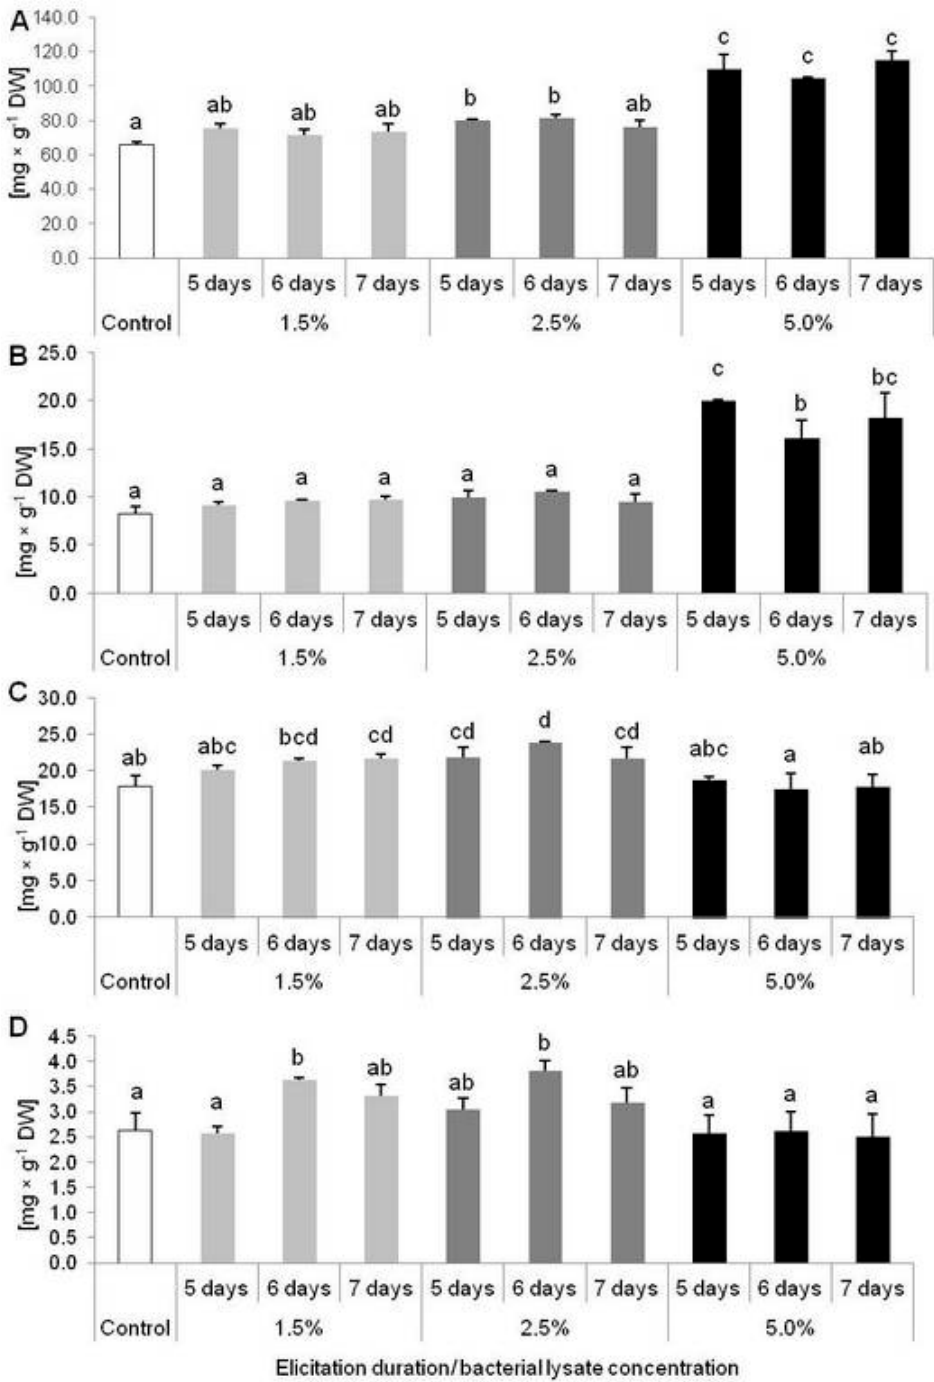
Figure 5. Accumulation of phenolic compounds in Dionaea muscipula plants after 5, 6 and 7 days of elicitation with Cronobacter sakazakii lysate in different concentrations: ( A ) total phenolic content; ( B ) of elicitation with Cronobacter sakazakii lysate in di ff erent concentrations: ( A ) total phenolic content; phenylpropanoids; ( C ) flavonoids; ( D ) anthocyanins; different letters—significant difference ( B )phenylpropanoids; ( C )flavonoids; ( D )anthocyanins; di ff erentletters—significantdi ff erencebetween between means at p < 0.05, bar—standard deviation. means at p < 0.05, bar—standard